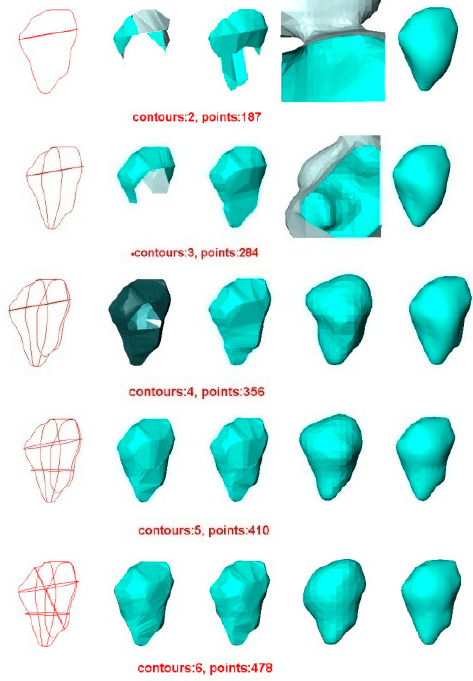
Figure 8. Surface reconstruction of one human liver tumor using four methods. For each row, from left to right: the contours used, the surface reconstructed by BPA, the surface reconstructed by Power Crust, the surface reconstructed by Poisson, and the surface reconstructed by VSR.